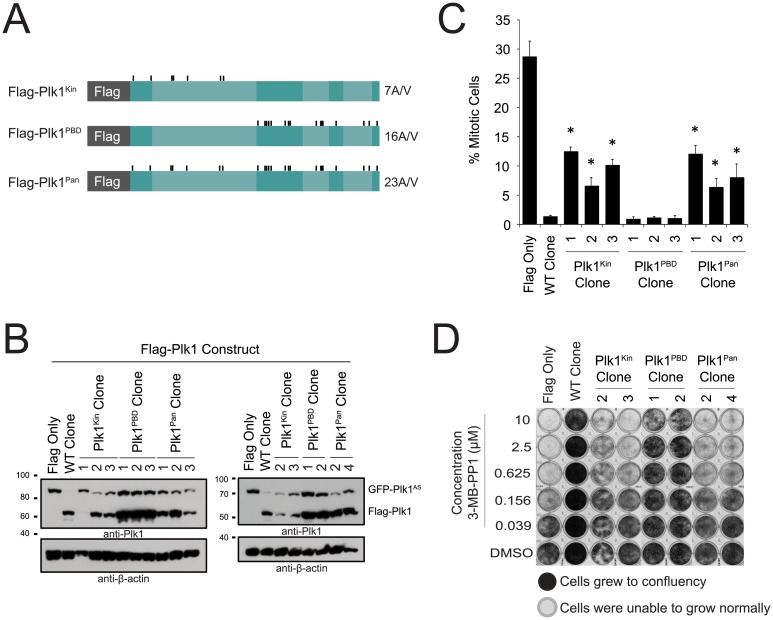
Plk1PBD rescues mitotic progression and cell proliferation.(A) Plk1AS is complemented with one of the indicated flag-tagged (analog resistant) rescue constructs. Flag-Plk1 is mutated at 23 phosphorylation sites (Plk1Pan, excluding T210 and T214) that were able to rescue in previous experiments. These 23 phosphorylation groups were then divided into two groups, based on domain. Plk1Kin has 7 mutations in the kinase domain, while Plk1PBD has 16 in the PBD region of the protein. (B) Western blot to show expression in indicated monoclonal cell lines probed with anti-Plk1 (upper) and anti-β-actin (lower) antibodies. (C) Mitotic index of AS cell lines from (B) treated with 3-MB-PP1 for 16 hours. 900 cells were scored as mitotic or non-mitotic through Hoechst staining. n≥3, *p<0.05 compared to WT Clone (GFP-Plk1AS/Flag-Plk1WT). (D) 6000 cells were plated in complete medium and treated with concentrations of 3-MB-PP1 as indicated, and allowed to grow until control wells were confluent (eight days). Cell density is qualitatively detected by crystal violet staining.